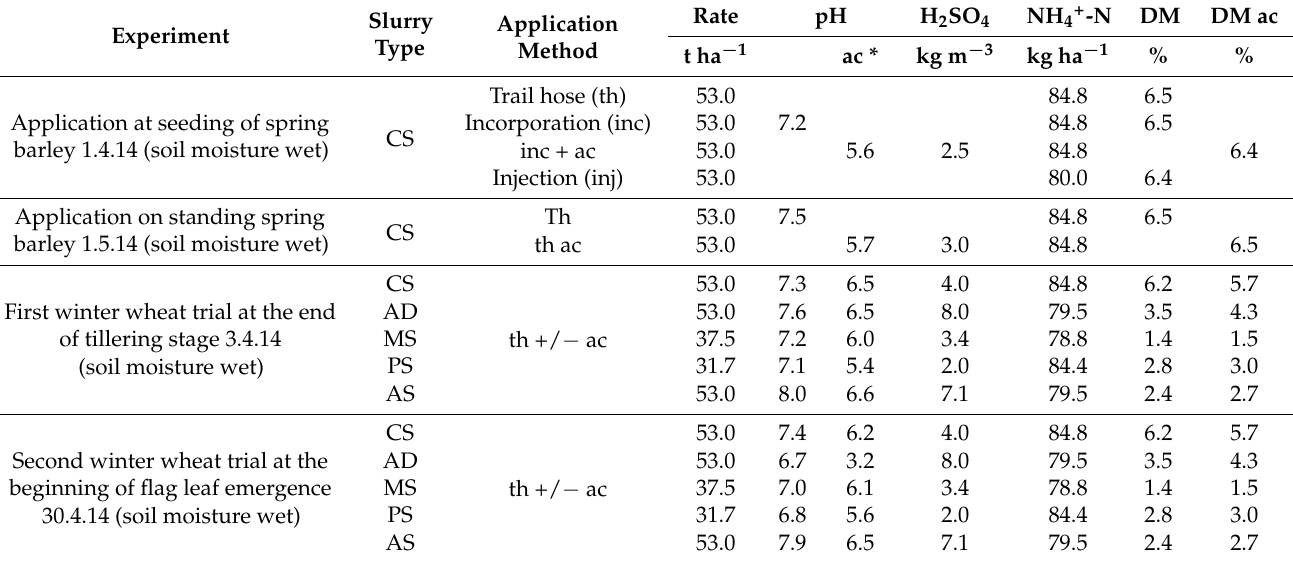
Table 2. Slurry types, slurry characteristics and application dates, methods and conditions of four slurry applications carried out on spring barley and winter wheat at Foulum Research Centre, Denmark (2014).